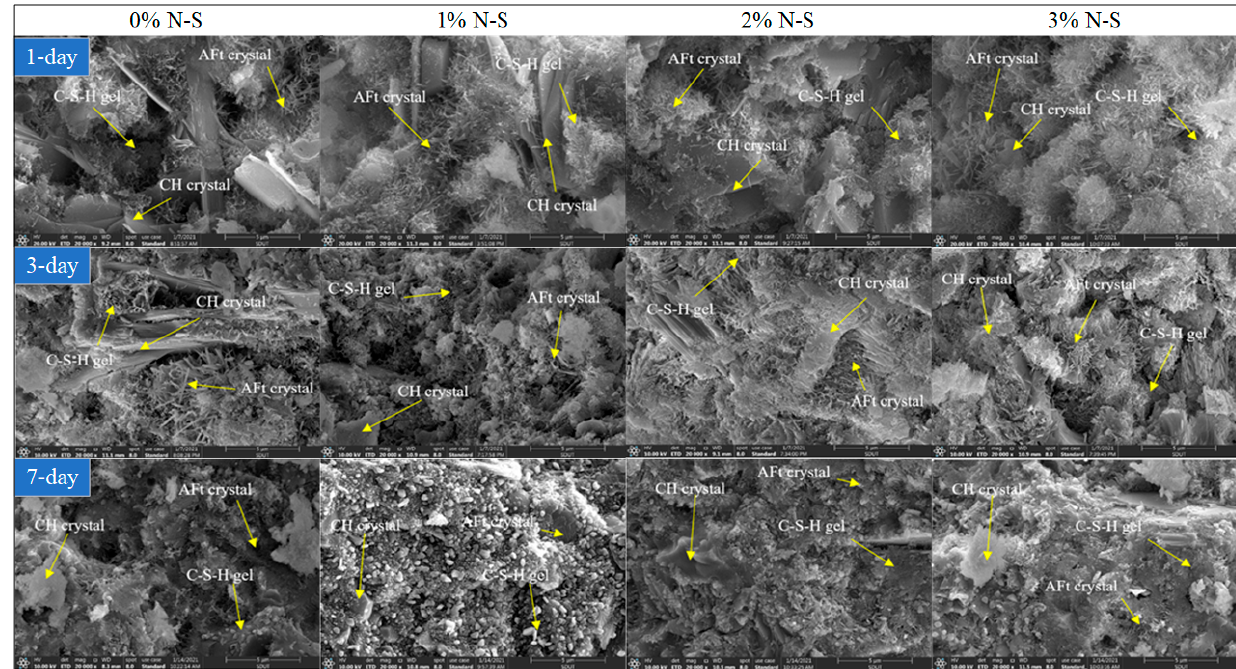
Figure 5. Microstructures of the cement grouting materials with the CRTS. (×20,000). The CH crystals, C ‐ S ‐ H gels, and AFt can be observed in each CRTS. The microstruc ‐